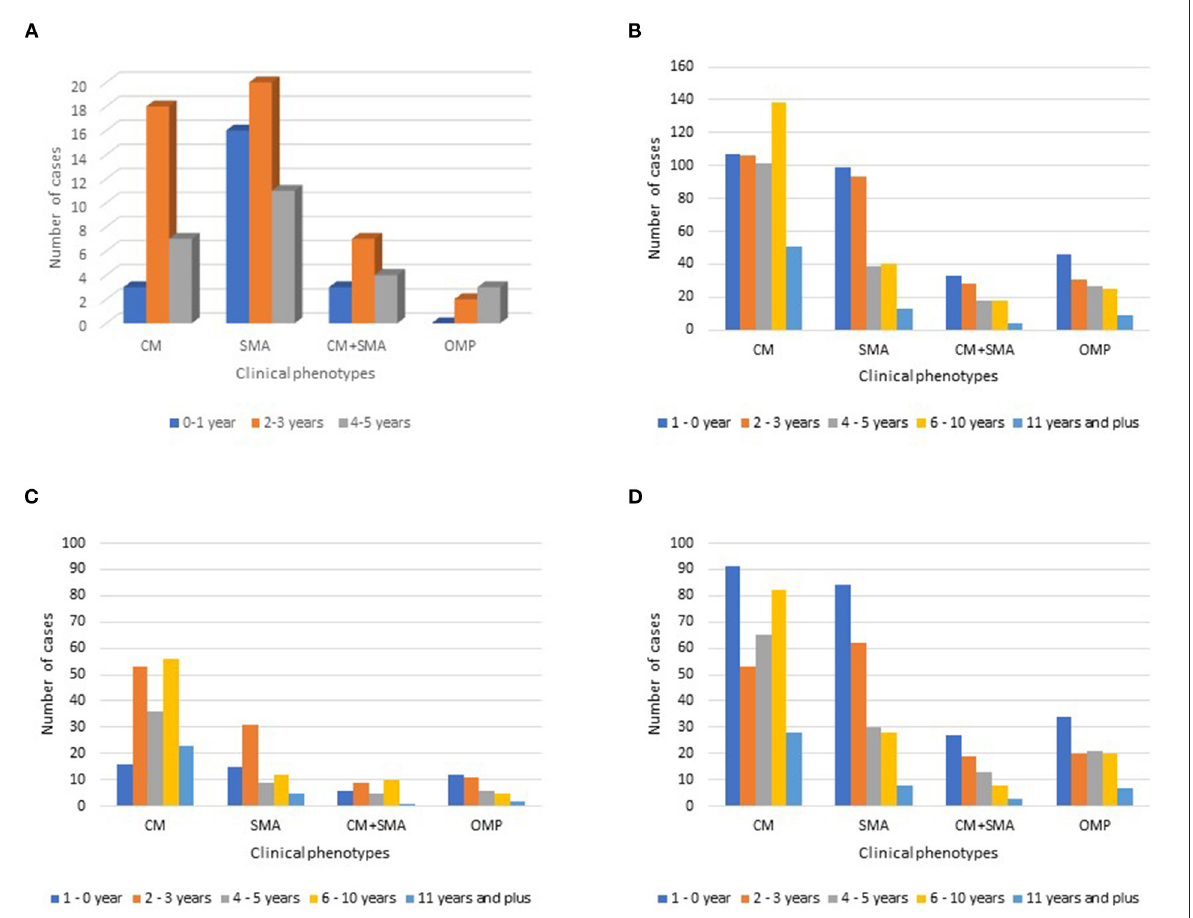
FIGURE1 Severe malaria clinical phenotype distribution by age group for (A) the case-control study and for (B) the National Hospital of Mali record survey. Also included is the severe malaria clinical phenotype distribution by age group for the National Hospital of Mali record survey from 2013 to 2015 (C) , prior to seasonal malaria chemoprevention introduction, and from 2016 to 2019 (D) , after seasonal malaria chemoprevention was initiated. CM, cerebral malaria; SMA, severe malarial anemia; CM + SMA, concurrent cerebral malaria and severe malarial anemia; Other